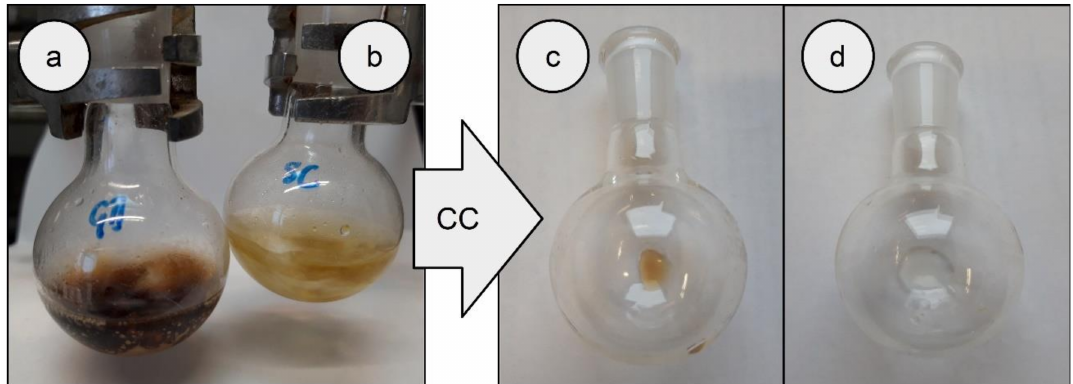
Figure 2. Reaction mixture after RCM and oxidation of S1 conducted under identical conditions using ( a ) Grubbs Ru0 and ( b ) StickyCat catalyst Ru5 . Product P1b isolated by column chromatography (CC) from ( c ) reaction with Ru0 and ( d ) with Ru5